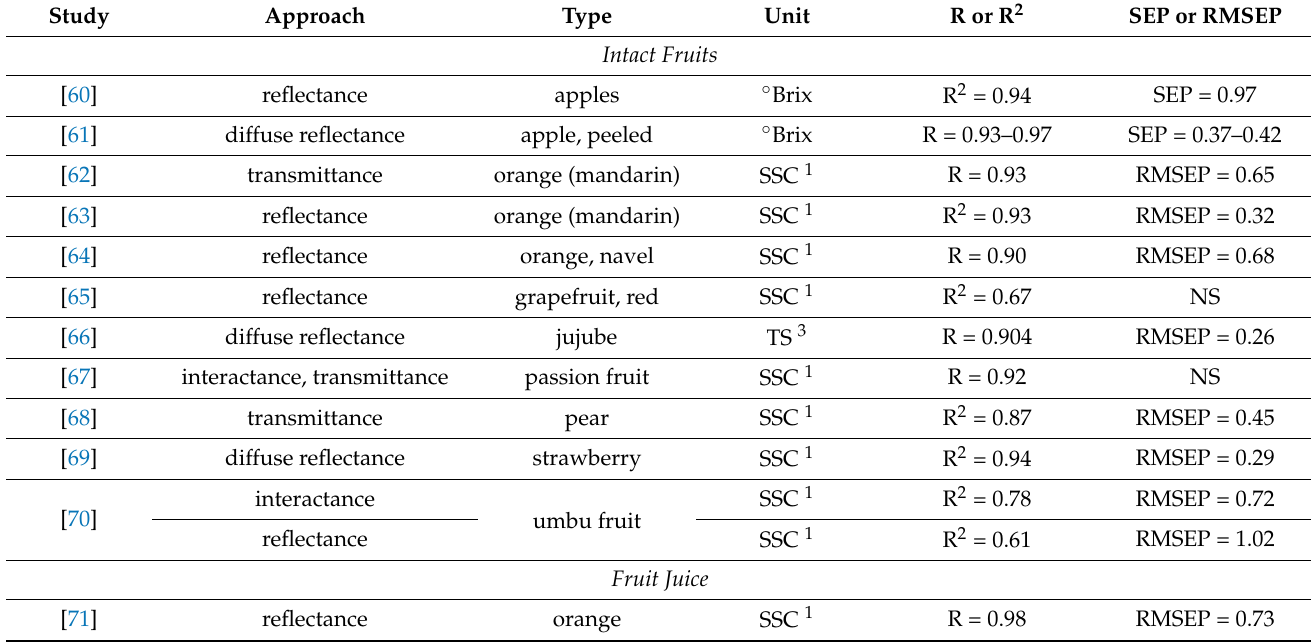
Table 5. NIR Spectroscopy for Measurement of Sugar Content in Fruit and Fruit Juice. NS: Not Studied; SEP: Standard Error of Prediction; RMSEP: Root Mean